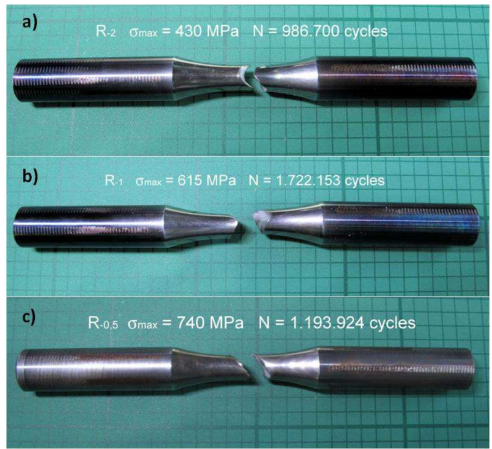
Figure 8. Fatigue fracture cross-section of a polished test specimen after 1,101,291 cycles with a maximum stress σ max = 1040 MPa in a R = 0.05 axial test.